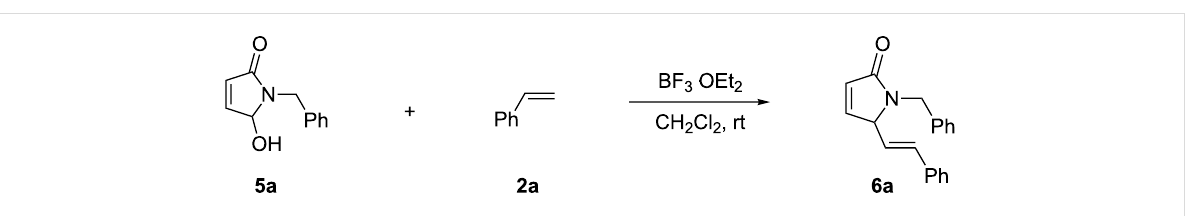
Scheme 2: Reaction of 5-hydroxypyrrol-1-one with